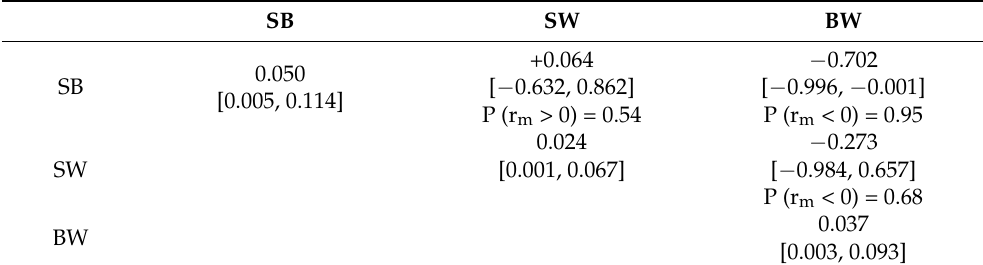
Table 7. Posterior means of phenotypic proportion of the maternal permanent effect (diagonal), and their correlations (above diagonal) for survival at birth (SB) and at weaning (SW), and individual birth weight (BW) after adjustment for litter